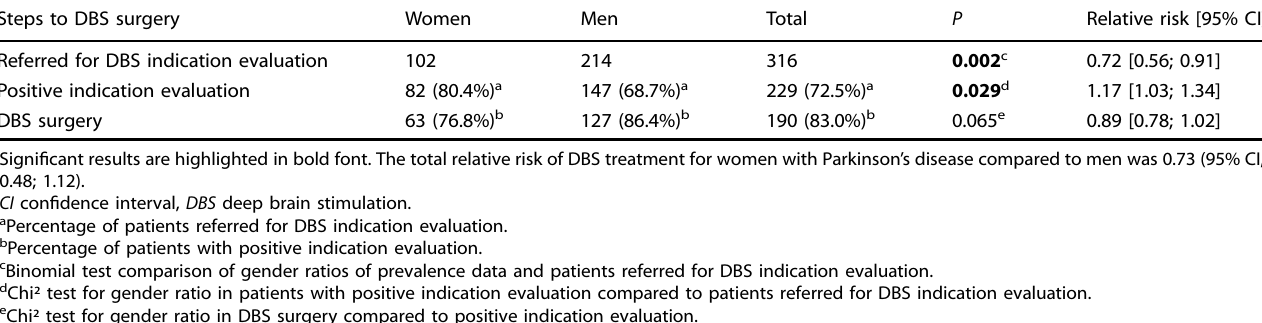
Table 1. Gender ratios at indication evaluations, approval for deep brain stimulation and surgical procedures in the cross-sectional cohort. Steps to DBS